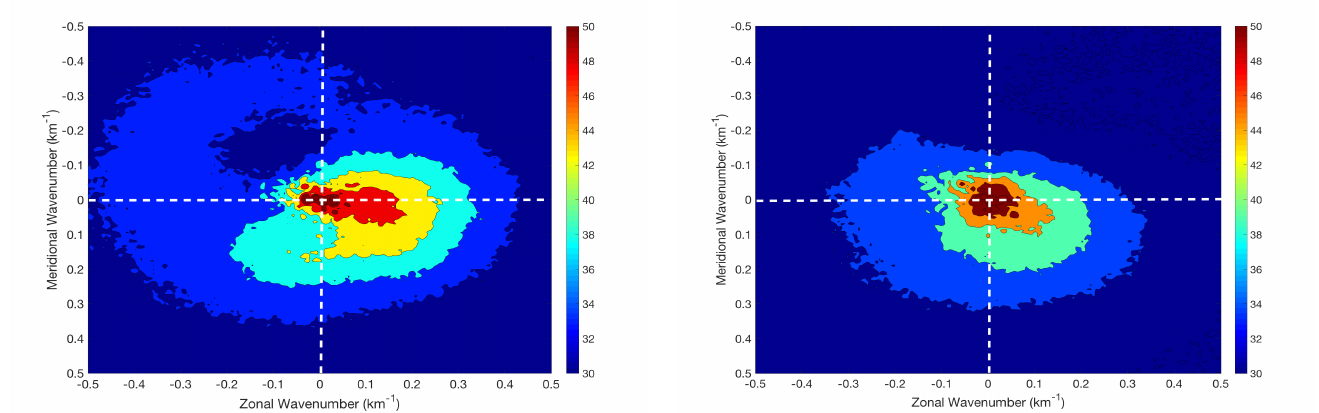
Figure 16. Left : Unambiguous horizontal wavenumber spectra (UHWS) from the OH images of the first part of the night, before midnight. Right : UHWS of the second part of the night, after midnight. The color bar in the 2D spectra is in logarithmic scale and represents the square of the magnitude (cyc/m) 2 . White dashed lines show the position of the zero